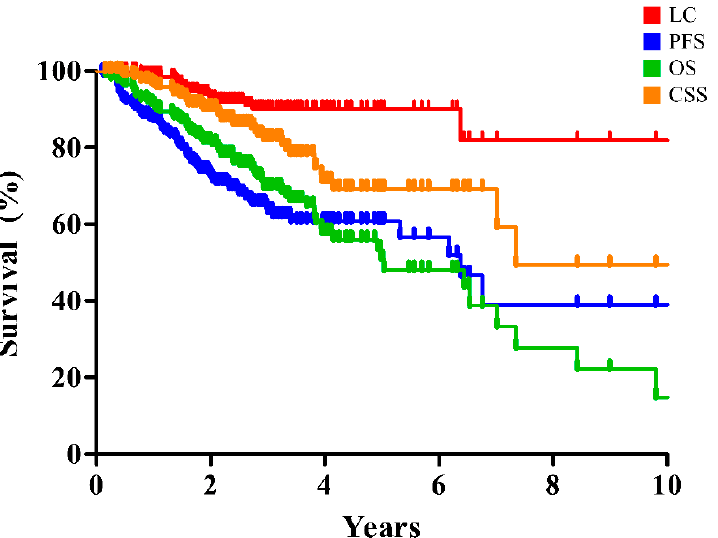
SBRT, stereotactic body radiation therapy; LC, local control; PFS, progression ‐ free survival; OS, overall survival; CSS, cause ‐ specific survival.